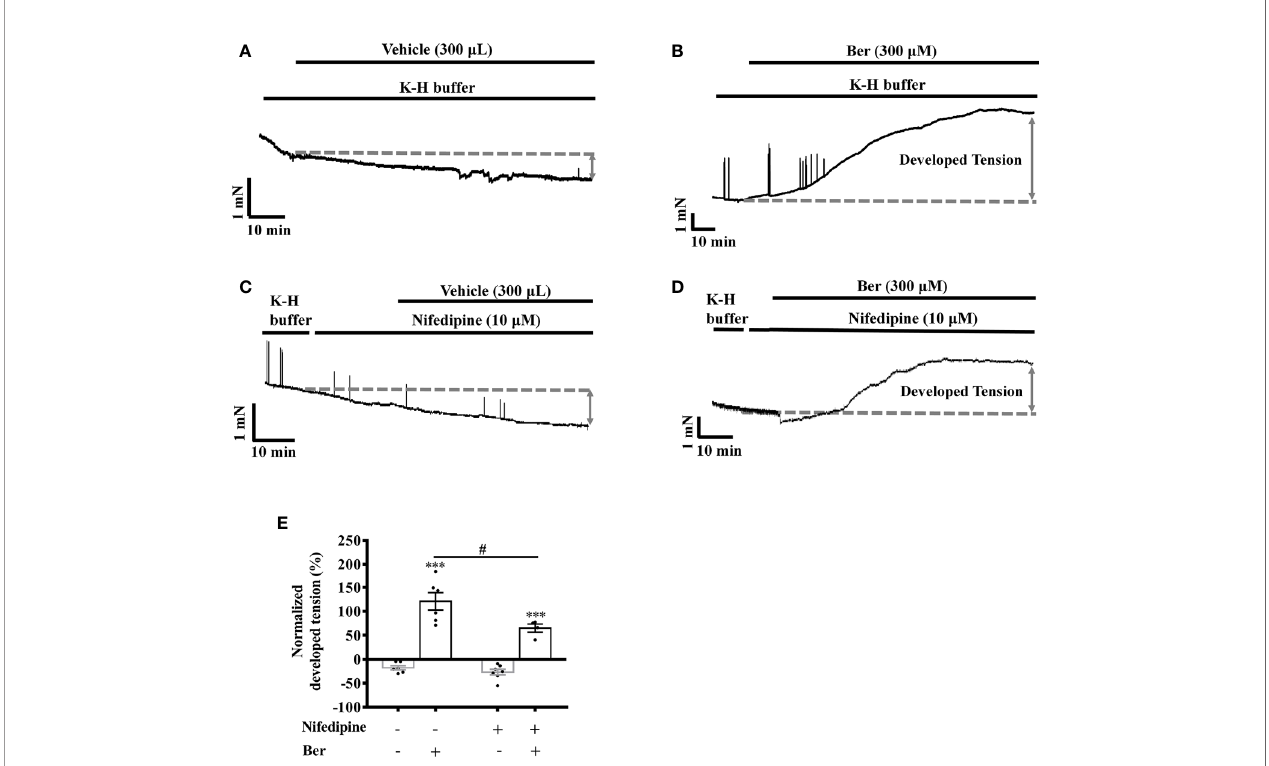
FIGURE 7 | Nifedipine attenuated the berberine-induced tension increase in left ventricular muscle (LVM) strips. (A – D) Original isometric tension recordings of the LVM strips treated with vehicle (A) , 300 m M Ber (B) , 10 m M nifedipine (C) , and 300 m M Ber in the presence of 10 m M nifedipine (D) , respectively. (E) Summary data showing nifedipine hindered the 300 m M berberine-induced tension increase in LVM strips. The numbers of repeats are as follows: vehicle control of 300 µM Ber, n = 6, N = 6; 300 µM Ber, n = 6, N = 6; 10 m M nifedipine, n = 7, N = 7; 300 µM Ber plus 10 m M nifedipine, n = 5, N = 5; n and N are the numbers of LVM strips and rats, respectively. Ber stands for berberine. ***p < 0.001 vs. vehicle control group; # p < 0.05, vs. 300 m M Ber-treated group; two-way ANOVA with Tukey's multiple comparisons